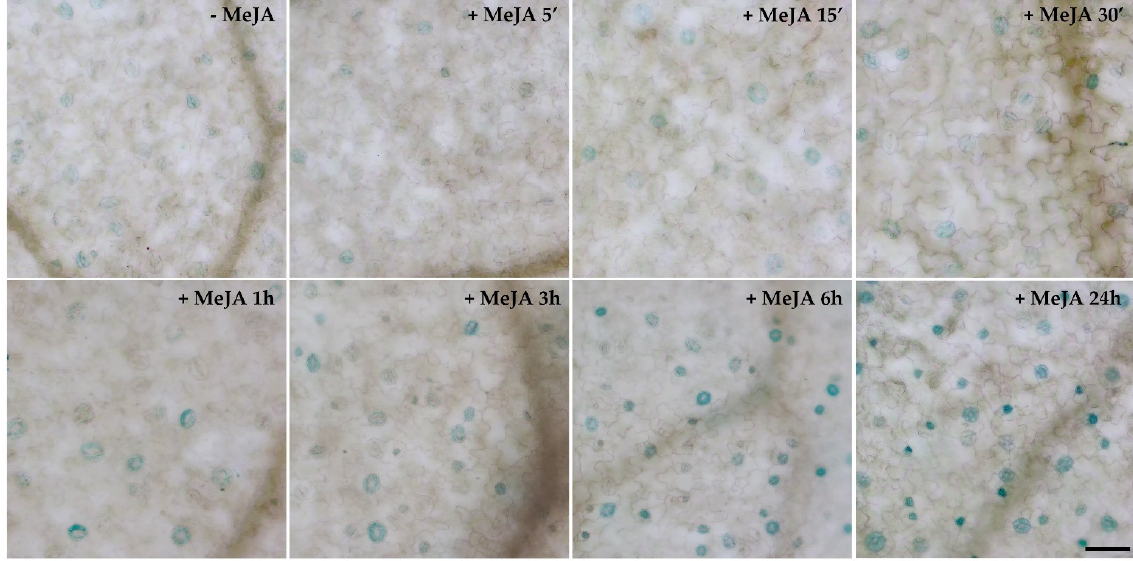
Figure 3. Analysis of AtCuAO β tissue-specific expression pattern upon treatment with 50 μ M MeJA. Light microscopy analysis by GUS staining in cotyledons of seven-day-old AtCuAO β :: GFP-GUS transgenic seedlings untreated (Figure S3) or treated with 50 μ M MeJA for 5 min, 15 min, 30 min, 1 h, 3 h, 6 h and 24 h. The staining reaction proceeded for 2 h. Micrographs are representative of those obtained from fifteen leaves from three independent experiments. Bar = 50 μ m.